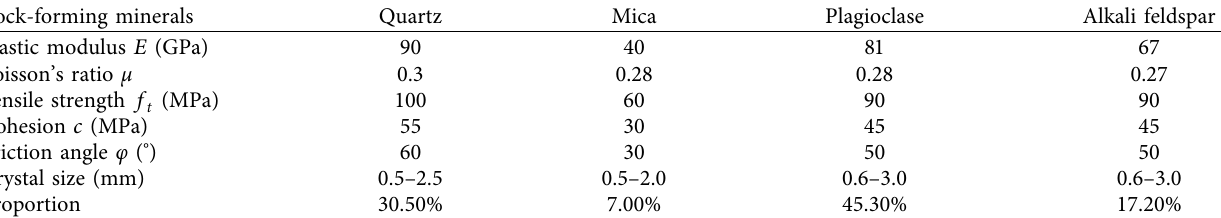
Table 1: Mechanical parameters of rock-forming minerals.